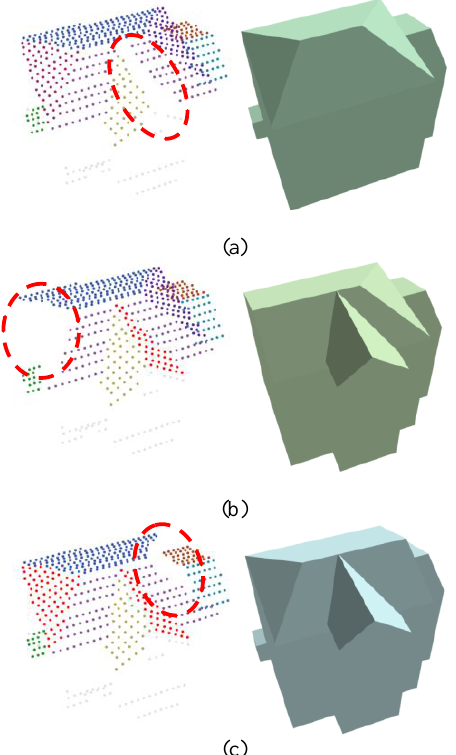
Figure 11. Reconstructed roof models (building in Figure 8d) from incomplete roof planes. (a)~(c): roof planes in the elliptical areas (left images) are missed.